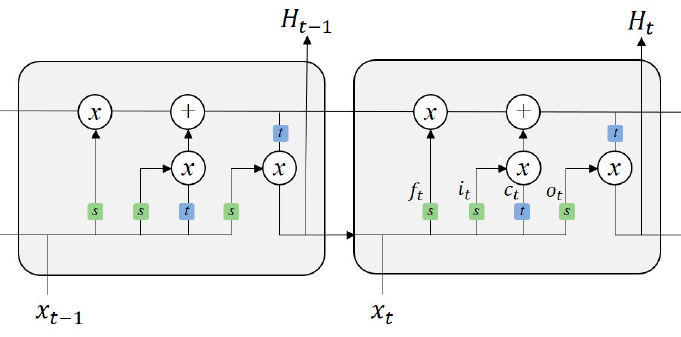
Figure 1. Structure of Long Short-Term Memory (LSTM) unit.